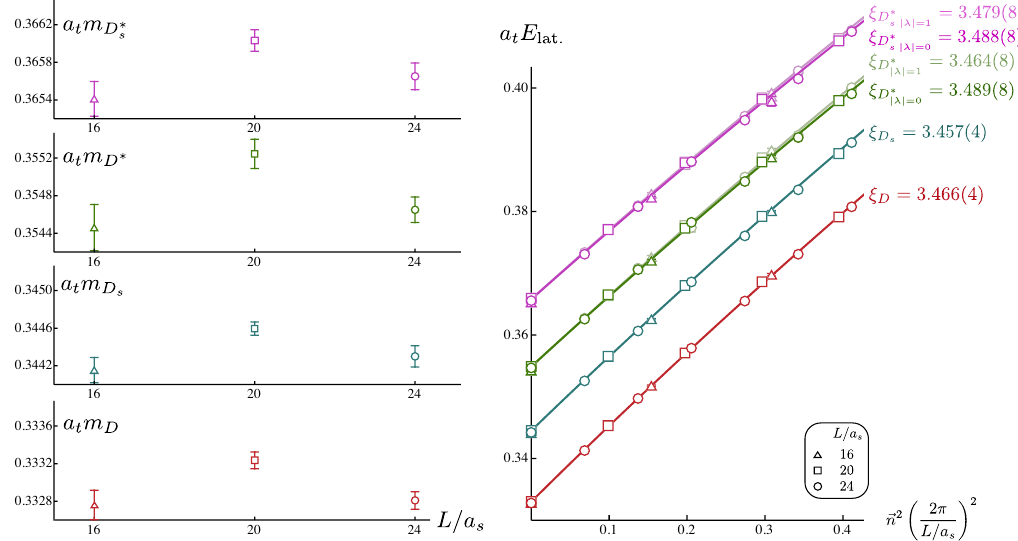
Figure 2 . Charmed meson masses and dispersion relation fits on the ensembles with m π = 391 MeV. Left panel shows meson masses extracted on each volume from a fit to the dispersion relation on that volume. Right panel shows the meson energies from all three volumes as a function of momentum and results of fits to the dispersion relation on the largest volume — these all give a reasonable fit to the